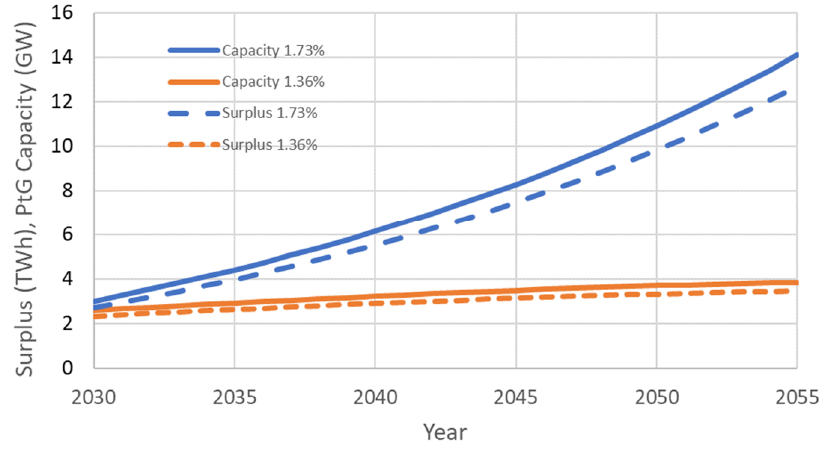
Figure 3. Estimated power-to-gas capacity (GW) needed to be installed in Spain to manage the energy surplus (TWh) from 2030 to 2055.